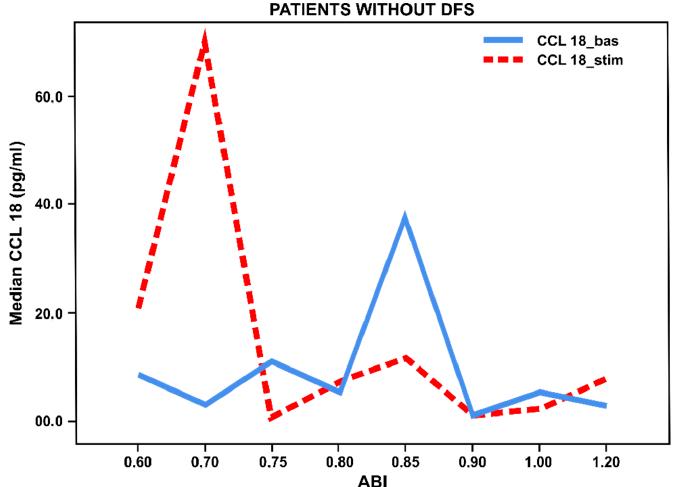
Figure 2. Basal and stimulated CCL18 secretion (pg/mL) by blood-derived monocytes from patients with long-term T2DM ( n = 51) without foot ulcers, depending on the ankle–brachial index (ABI). Lines reflect median values.